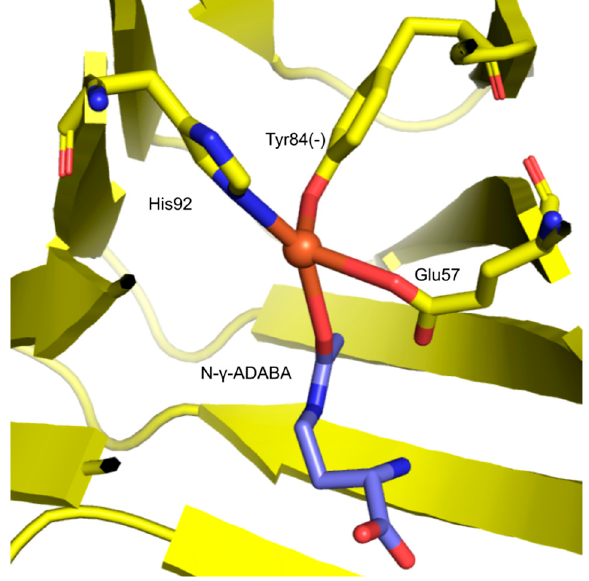
Figure 12. Zoom view into the model with tetrahedral geometry around the Fe 2+ ion; bonded force field model with parameters listed in Table S1.